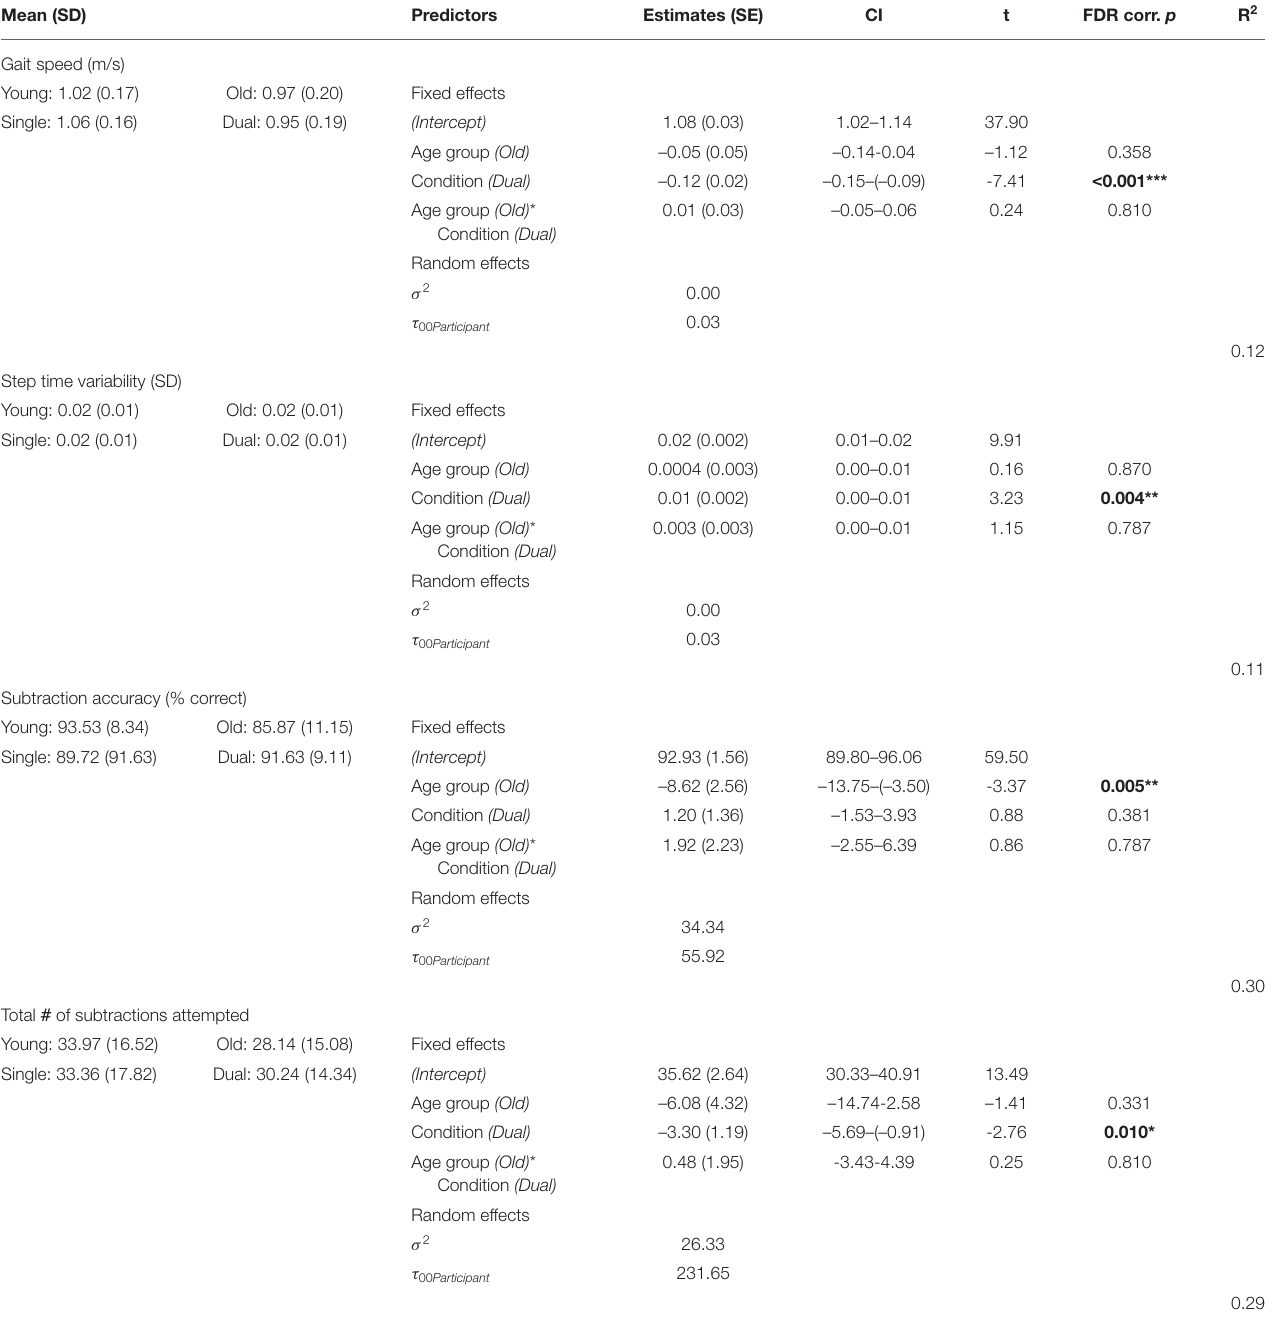
TABLE 2 | Age and condition differences in gait and subtraction